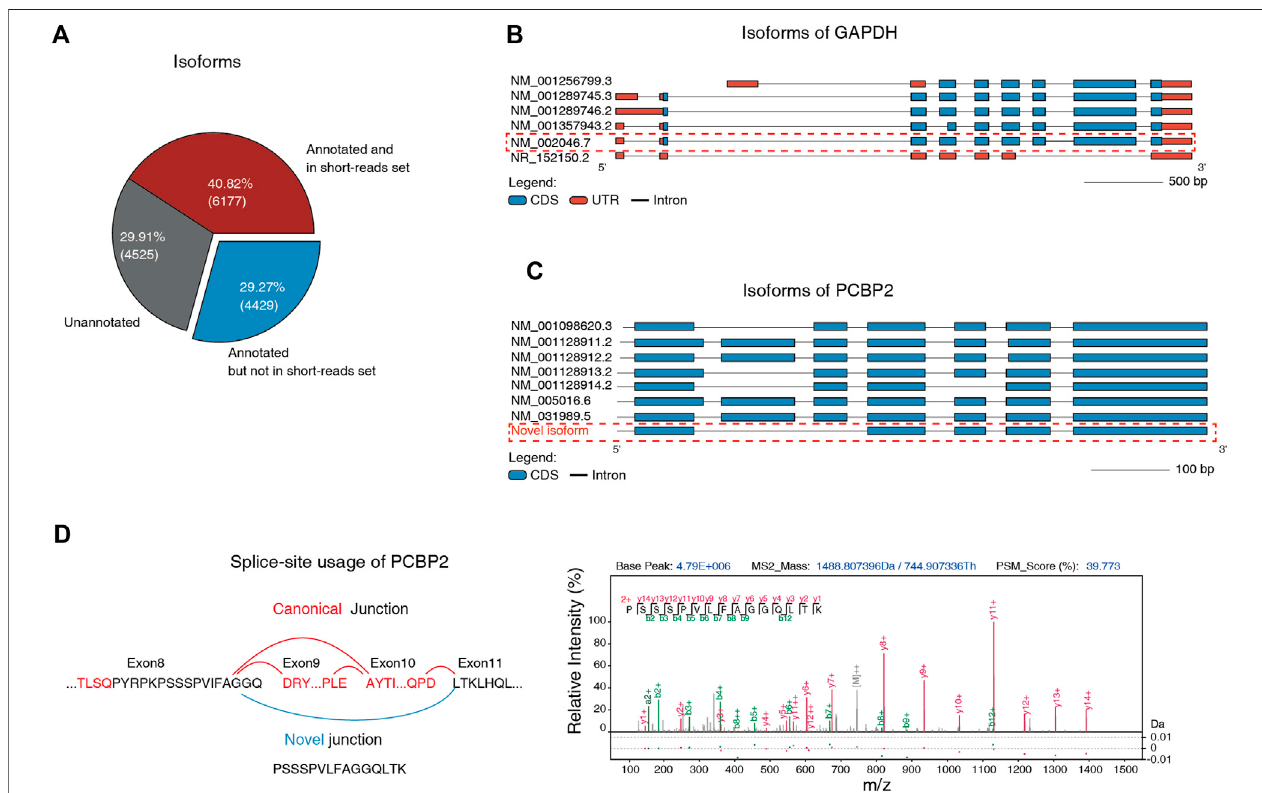
FIGURE 3 | Single-molecule full-length RNC-seq improved the ef fi ciency of isoforms identi fi cation. (A) Three types of identi fi ed isoforms by Nanopore RNC-seq. “ Annotated ” meansthattheisoformisincludedinNCBIhumanRefseqdatabase. “ inshort-readset ” meansthattheisoformcanbeidenti fi edbyshort-readRNC-seq. (B) AllisoformsofGAPDH.Themarkedisoformwasidenti fi edbyfull-lengthRNC-seqbutnotbyshort-readRNC-seq. (C) AllisoformsofPCBP2.Nanoporefull-lengthRNC- seq identi fi ed a novel isoform that was absent in Refseq and neXtProt databases. (D) The MS-detected speci fi c junction peptide (PSSSPVLFAGGQLTK) that supported the novel junction of